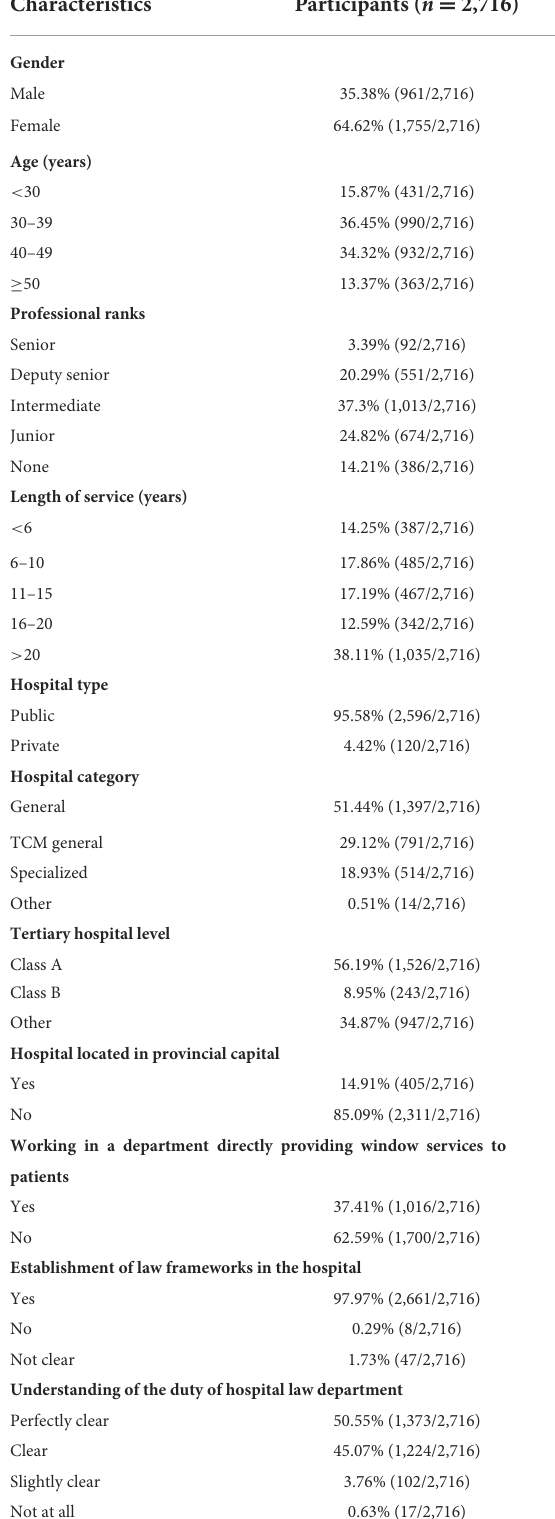
TABLE 1 Administrator’s basic characteristics, hospital levels, and the construction status of the rule of law in their